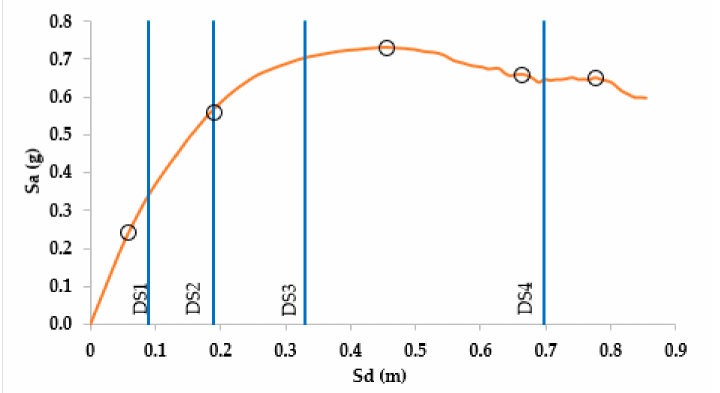
Figure 12. A plot of damage state threshold in the capacity spectrum.